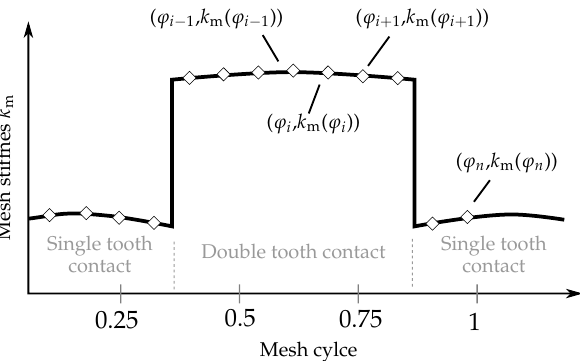
Figure 4. For a sequence of n different angular positions ϕ i , static FE simulations of a gear stage are performed, in order to obtain a set of n corresponding mesh stiffness values k m ( ϕ i )